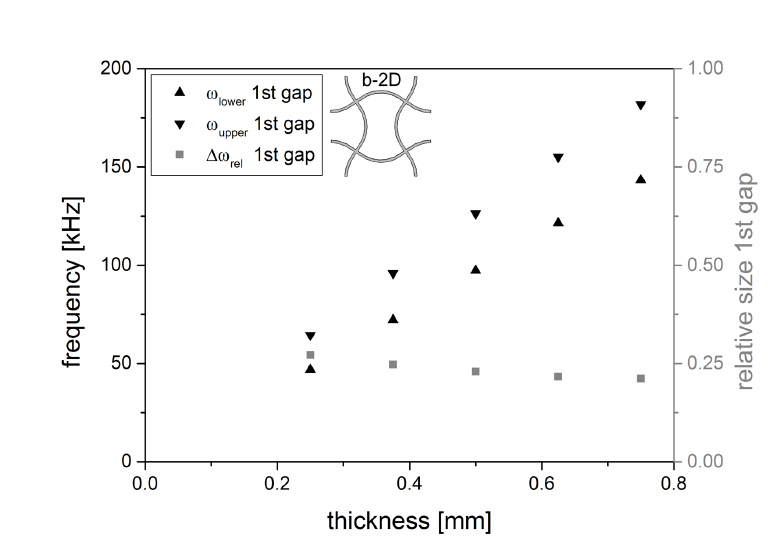
Figure 9. Lower and upper frequency of the 1st gap of structure b-2D as a function of the strut thickness (l = 5.0 mm, A = 1.0 mm) as well as the relative size ∆ ω rel of the 1st band gap.